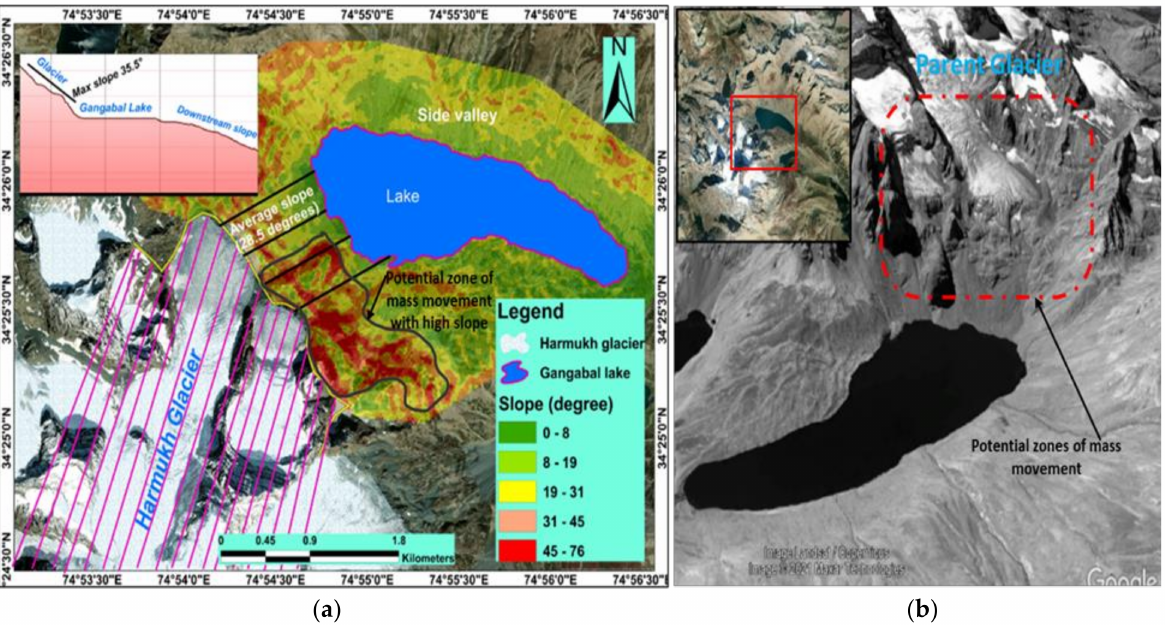
Figure 11. ( a ) Slope map showing potential zones of mass movement between the glacier and lake. ( b ) Potential zones of mass movement on Google Earth